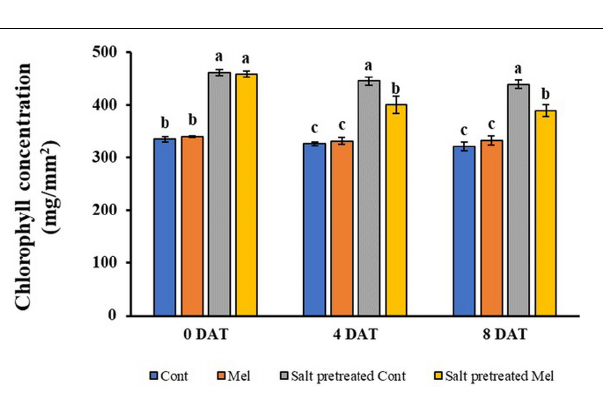
FIGURE 4 | Effect of melatonin with/without salt stress on chlorophyll content in green mustard seedlings. The results were calculated from data for 4 (4DAT) and 8 (8DAT) days. Treatment: control + water, control + 1 µ M melatonin, 150 mM salt pre-treatment + water, 150 mM salt pre-treatment + 1 µ M melatonin. Values show the means ± SE ( n = 3). Letters represent significant differences at p < 0.05 in accordance with Duncan’s multiple range